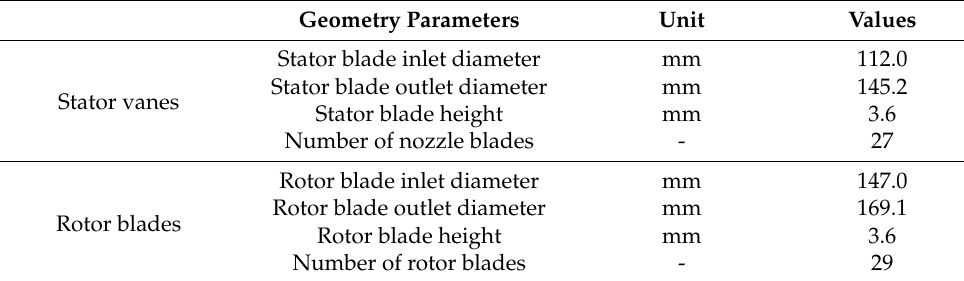
Table 2. The main geometry parameters of stator/rotor